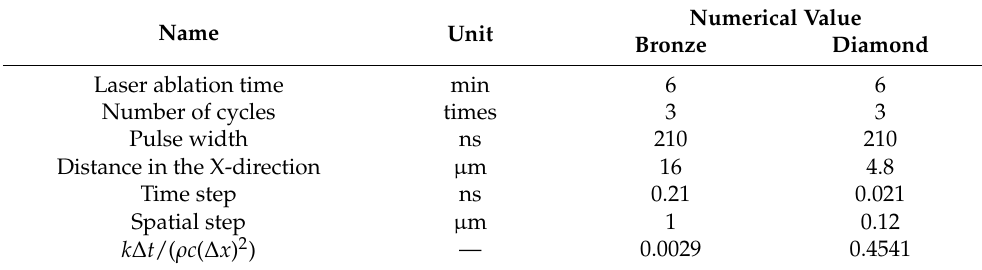
Table 3. Combined calculation